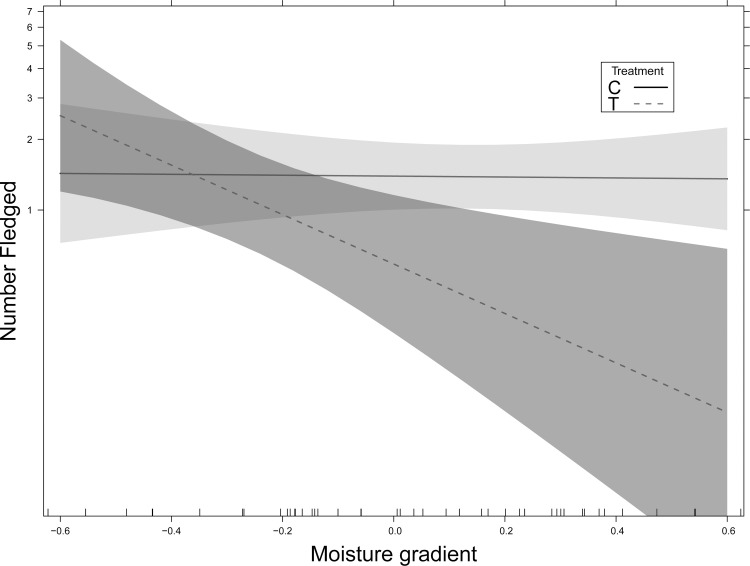
The relationship between number of fledged young and the interaction of forest habitat type and NMDS axis 1.Unaltered habitat = solid line; selective harvest habitat = dashed line with 95% confidence intervals.